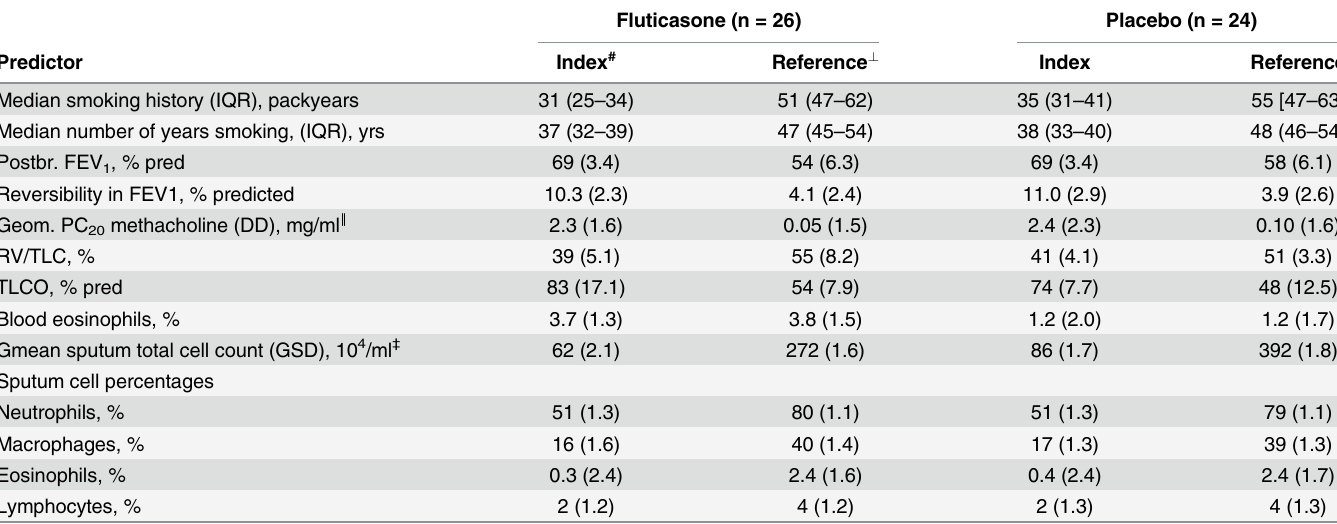
Table 3. Mean values of predictors per stratum per